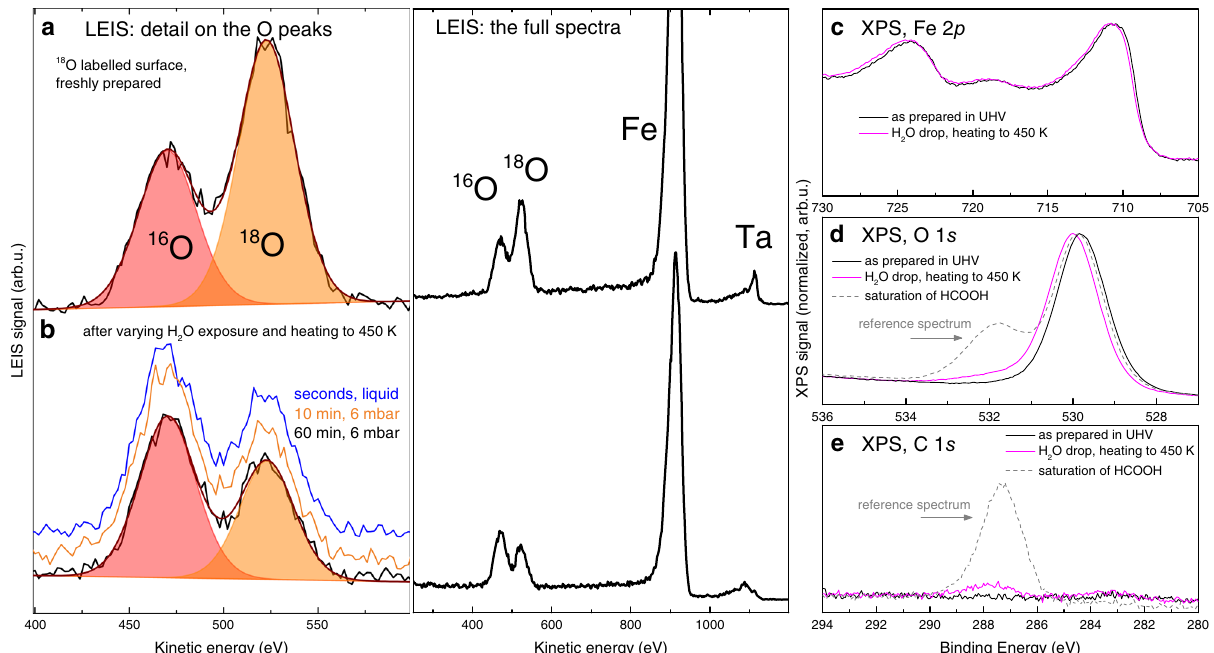
-- Fig. 3 LEIS and XPS characterization of the α -Fe 2 O 3 (1 102) surface before and after near-ambient pressure and liquid water exposures. a LEIS spectrum of the freshly prepared 18 O-labelled surface (1.225 keV He + , scattering angle 137°). b LEIS spectra taken after prolonged exposure to 6 mbar H 2 16 O and short liquid exposure show that ≈ 33% of the probed O is exchanged. Spectra are offset for clarity. c – e XPS spectra (Mg K α , 70° grazing emission) taken after surface preparation (black) and after 5 min. liquid water exposure (magenta). After the liquid water exposure, a small C signal appears, related to carbonaceous contamination. From comparison to reference spectra (dashed gray) this carbonaceous signal amounts to 5 – 30% of room-temperature saturation of HCOO − . Spectra shown in c , d are normalized to maximum, spectra shown in e are normalized to the background. Source data are provided as a Source Data fi